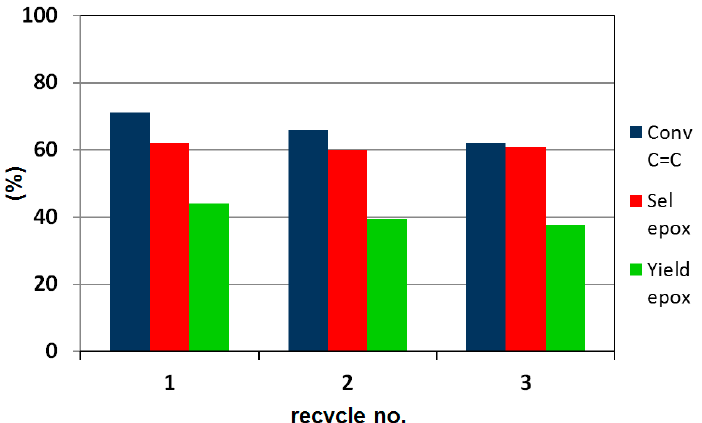
Figure 8. Catalytic performance of the recycled NbO x -SiO 2 catalyst in the epoxidation of karanja FAME mixture over. Conditions: 200 mg catalyst (at the 1st catalytic run), 2 mmol C = C substrate, 8 aq. H 2 O 2 , 90 °C, 4 h, 300 rpm, 10 mL CH 3 CN.